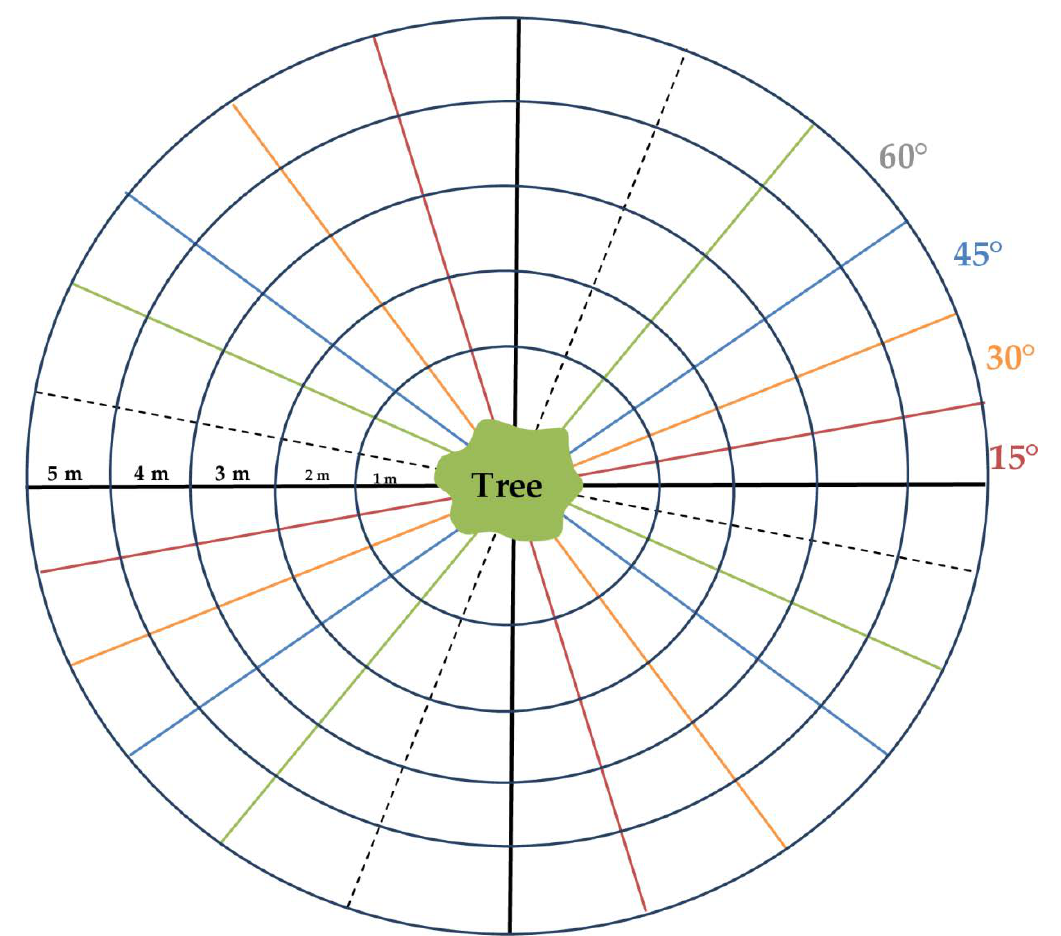
Figure 2. Illustration of image acquisition scenarios.